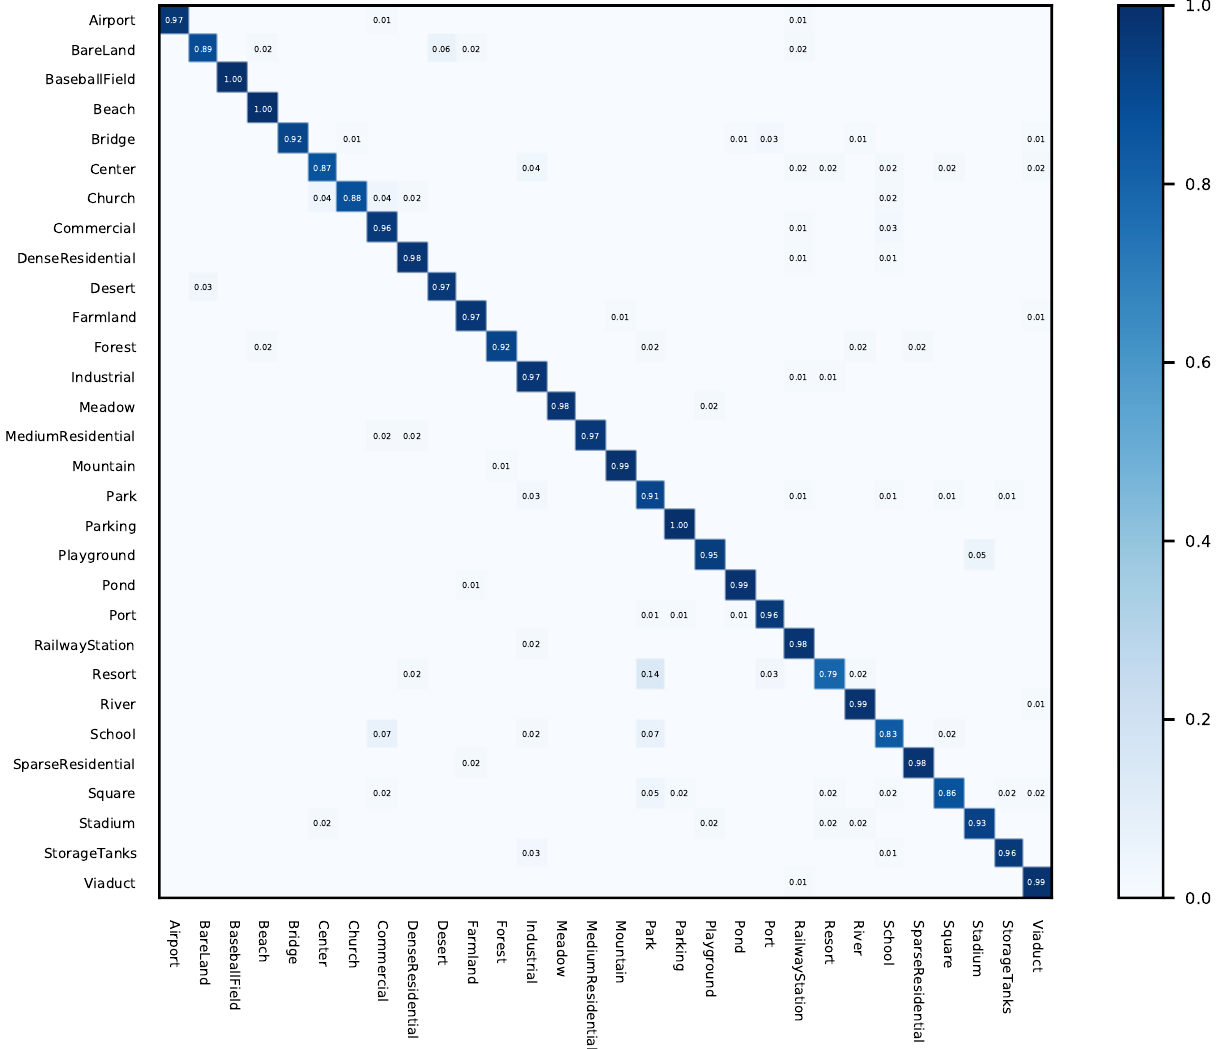
categories become much separable. This means that the large within-class diversity and high between-class similarity are effectively reduced.